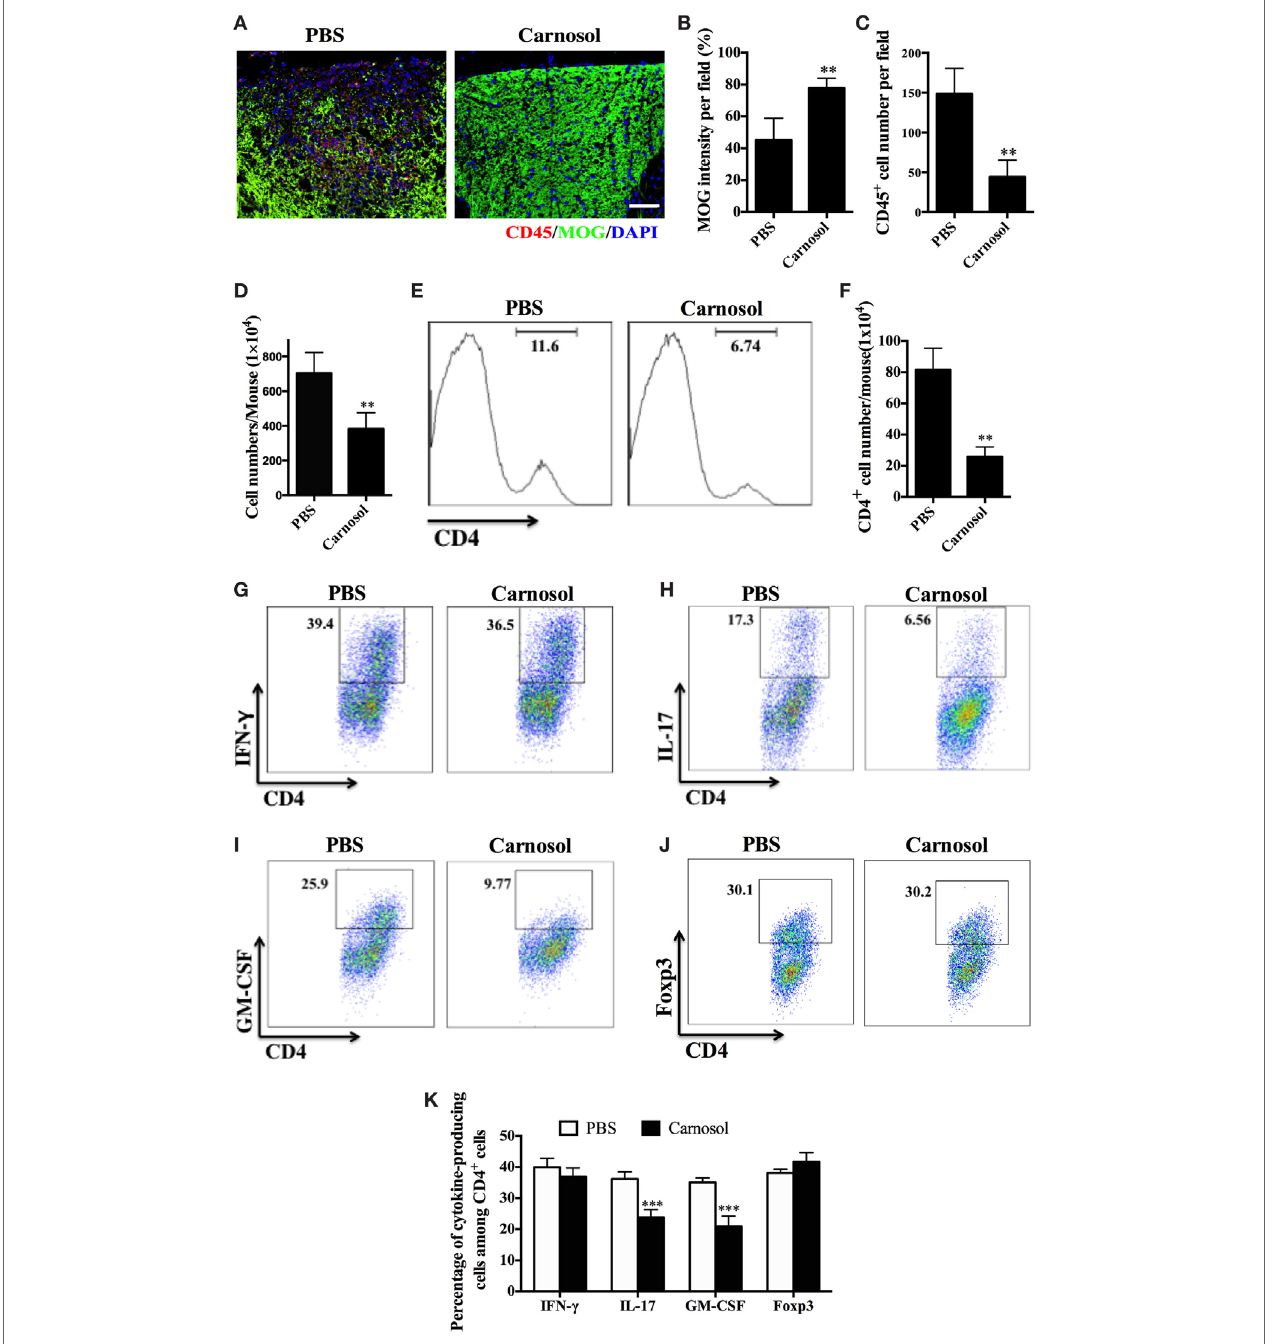
FigUre 2 | Carnosol treatment suppressed inflammatory infiltration in the central nervous system (CNS). Mice were treated with PBS or carnosol at the day of experimental autoimmune encephalomyelitis induction and sacrificed at day 30 p.i. (a) Spinal cords were subjected to immunostaining analysis. (a) Representative sections of thoracic spinal cord from PBS- and carnosol-treated mice were stained with CD45 and MOG (scale bar = 100 μ m), and the number of CD45 + cells (B) and the intensity of MOG staining (c) were statistically analyzed. (D) Spinal cords and brains were harvested and mononuclear cells (MNCs) isolated ( n = 10 each group). Total MNC numbers in CNS were counted under light microscopy. (e) The percentage of CD4 + T cells was measured by flow cytometry. (F) Absolute numbers of infiltrated CD4 + T were calculated by multiplying the percentages of these cells with total numbers of MNCs in each spinal cord and brain tissue. (g–J) Frequencies of IFN- γ + , IL-17 + , GM-CSF + , and Foxp3 + cells among CD4 + cells were assessed by flow cytometry, and (K) the percentages of these cells in total CD4 + cell numbers in each CNS are shown. Symbols represent mean ± SD ( n = 5 each group). ** p < 0.01 and *** p < 0.001. Student’s t -test. One representative of three independent experiments is shown.